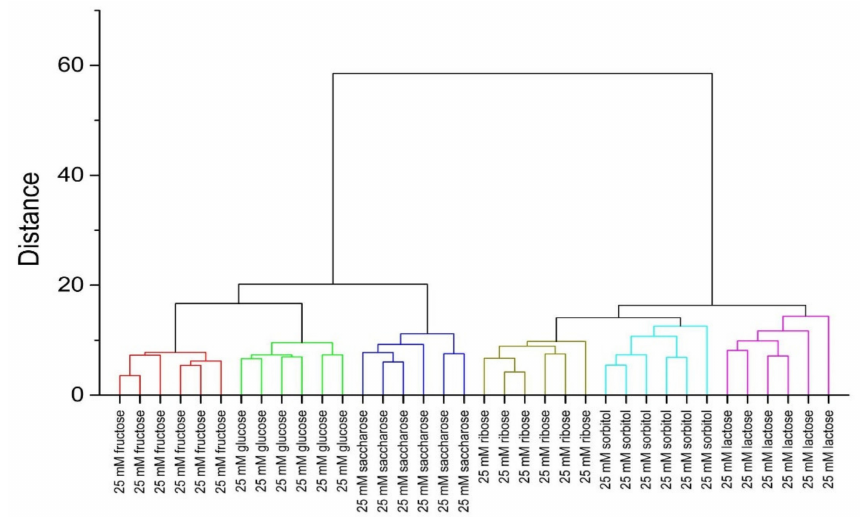
Figure 7. HCA dendrogram for samples containing studied receptors, ARS, and saccharides (25 mM).